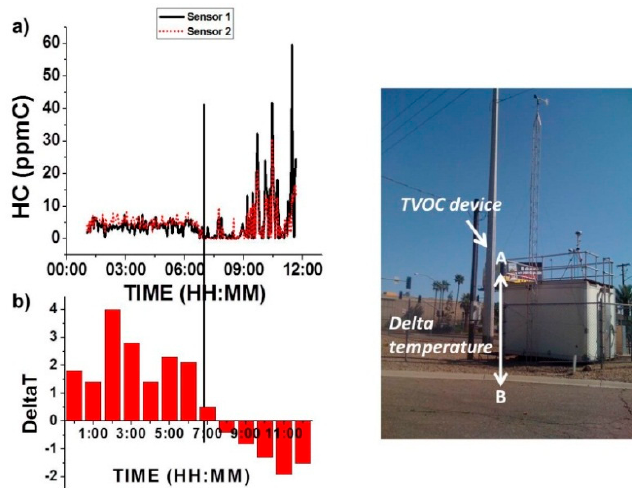
Figure 8. ( a ) VOC device’s real-time hydrocarbon concentration test at point A; ( b ) Corresponding delta temperature between points A and B. Height between point A and B was 14 ft.